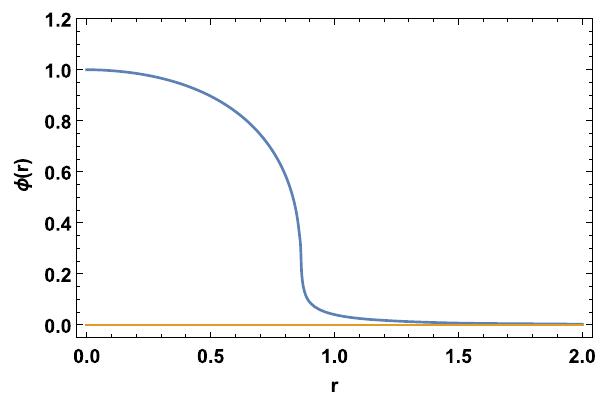
Fig. 2 The radial dependence of the scalar φ( r ) for the elastic body solution shows a decay at infinity with an exponential Yukawa-like dependence